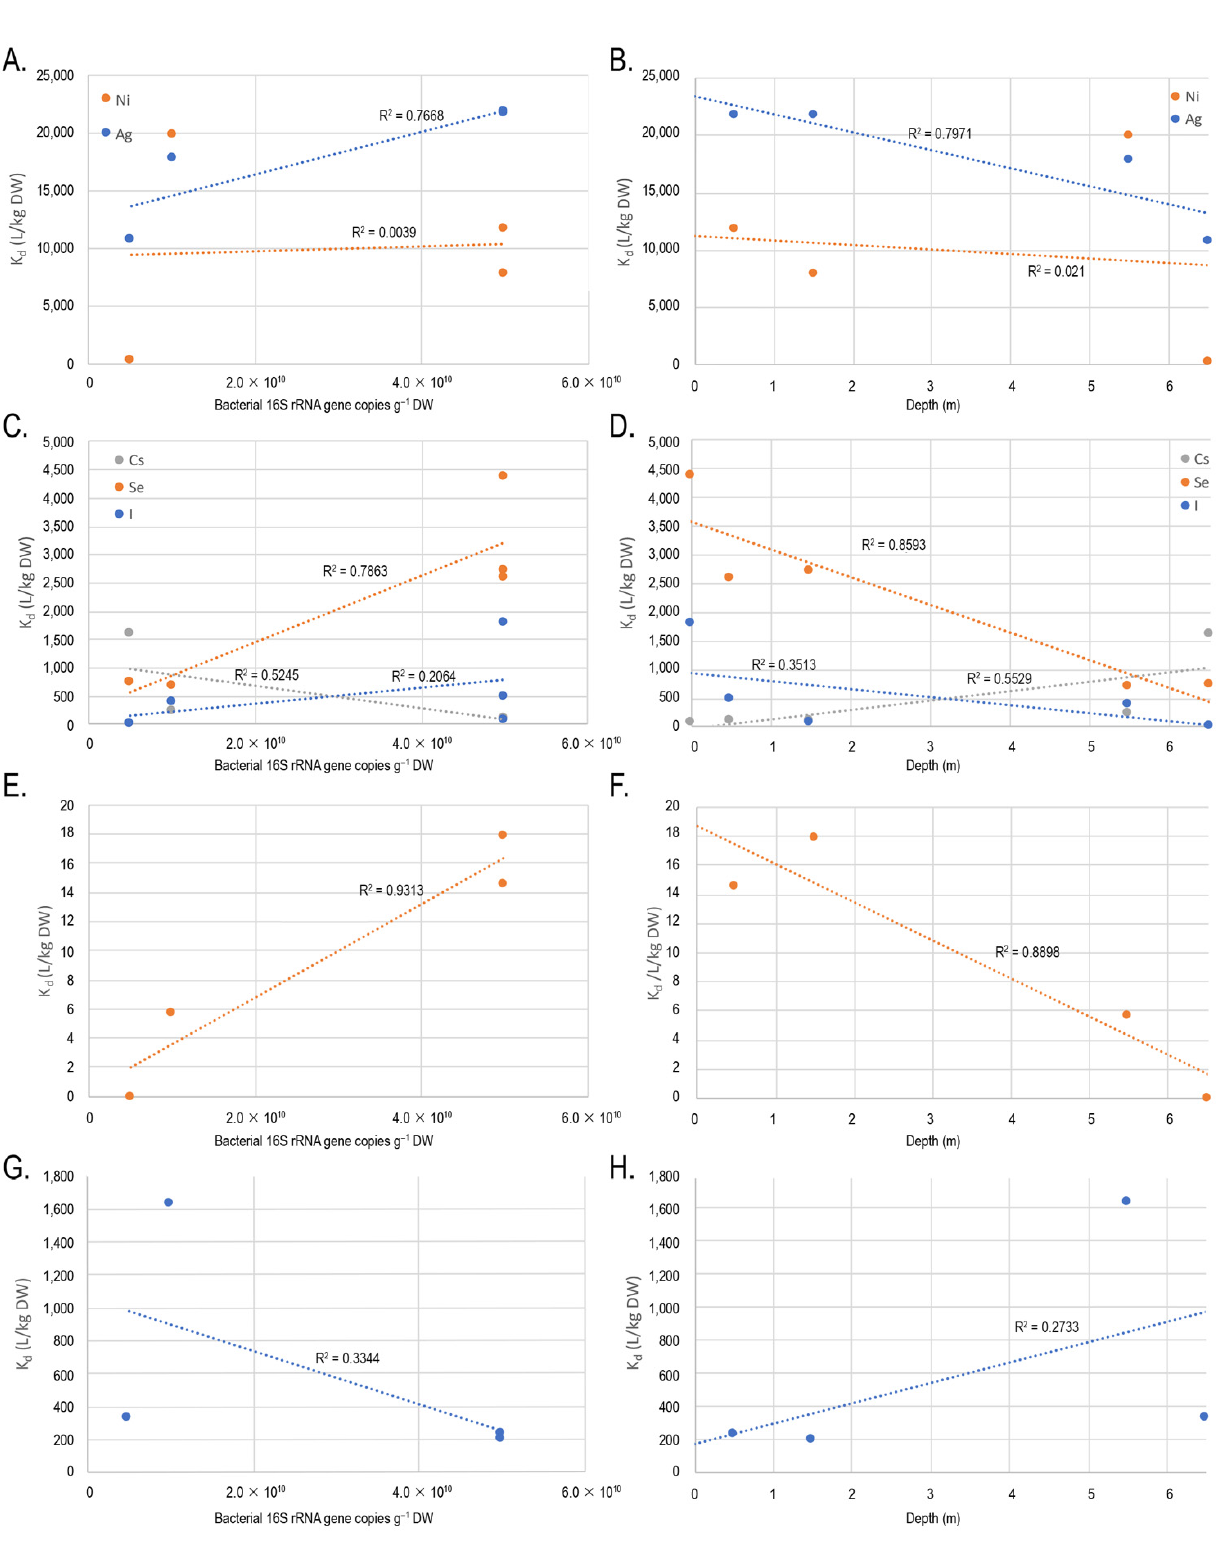
Figure 7. The sorption (K d ) of ( A , B ) Ni and Ag; ( C , D ) Cs, Se, and Ag; ( E , F ) anoxic Se; and ( G , H ) anoxic I plotted against ( A , C , E , G ) bacterial numbers (16S rRNA gene copies g − 1 DW) and ( B , D , F , H ) sampling depth, i.e., sample type.